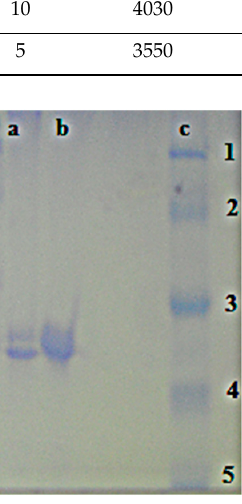
Table 1. Summary of purification procedure for human carbonic anhydrase (hCA) I, and II from fresh human erythrocytes with Sepharose-4B- L -tyrosine-sulphanilamide affinity chromatography.